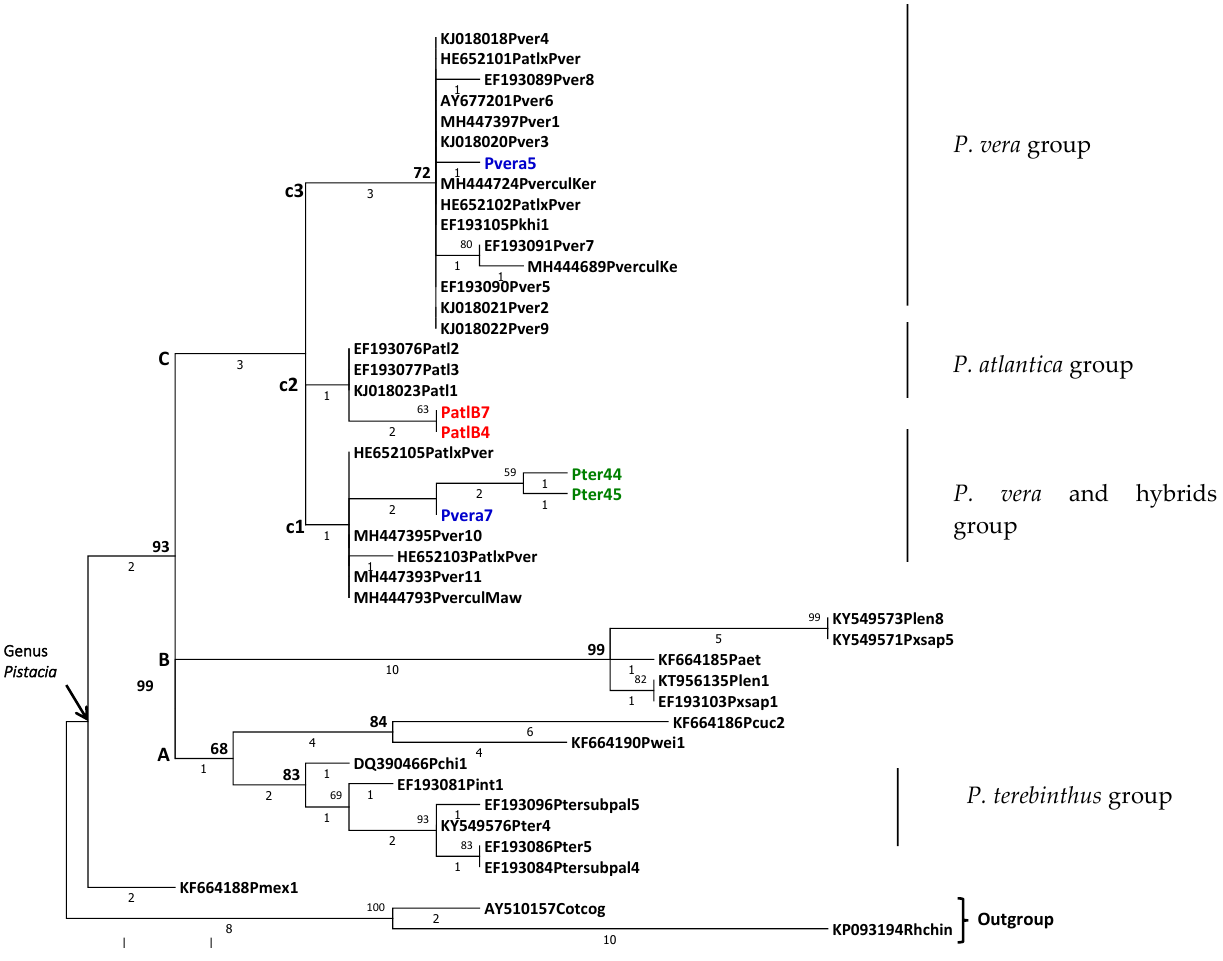
Figure 3. Phylogenetic tree of Pistacia pecies based in Maximum Parsimony analysis of taxa. The evolutionary history was inferred using the Maximum Parsimony method. The most parsimonious tree with length = 86 is shown (Figure 3). Bootstrap values (with 1000 replicates) are shown above the branches when they are greater than 70. Below the inner branches, the numbers of synapomorphy changes are given, and the terminal branches give the numbers of autapomorphy. Newly sequenced samples are coloured blue for P. vera , green for P. terebinthus and red for P. atlantica Desf. The consistency index is (0.725806), the retention index is (0.912371) and the composite index is 0.729897 (0.662205) for all sites and parsimony-informative sites (in parentheses). The percentage of replicate trees in which the associated taxa clustered together in the bootstrap test (636 replicates) is shown next to the branches [28]. The MP tree was obtained using the Subtree-Pruning- Regrafting (SPR) algorithm [29] (p.126) with search level 1, in which the initial trees were obtained by the random addition of sequences (10 replicates). The names of the samples are indicated as accession number, initials of the species name and clone number (see Ta- ble 1). 4. Discussion Our results show a relatively high variability of ITS1 sequences within the genus Pis- tacia (about 16%) (Table 2), indicating that the ITS1 region appears to contain a good